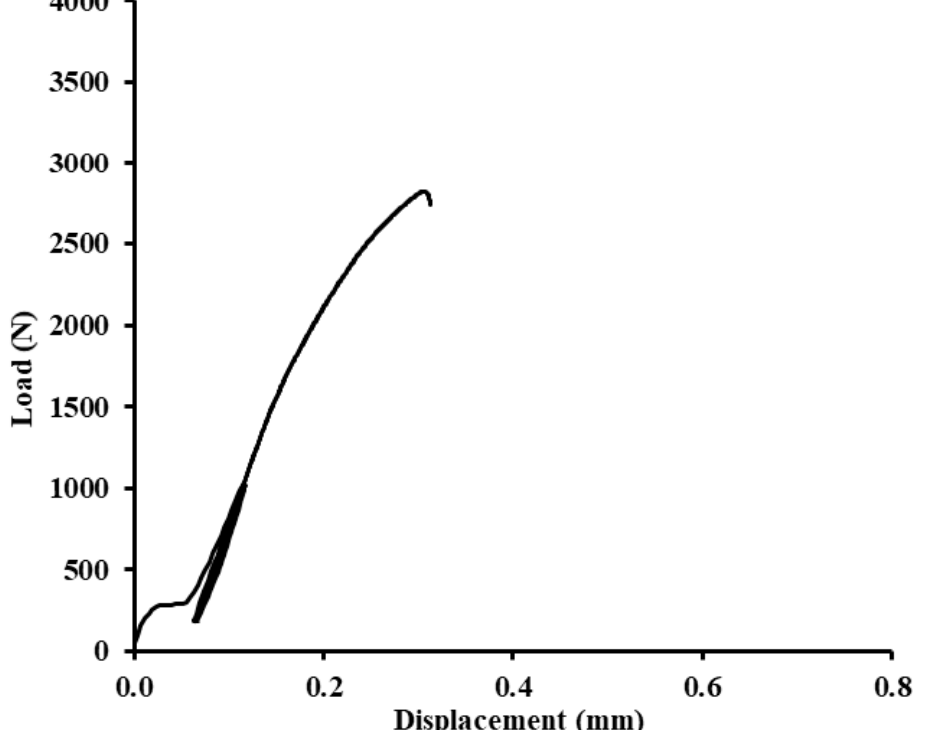
Figure 12. Quasi-static graph of adhesive bond ABFE1 with loading 5–30% (165–989 N)—1000 cycles.